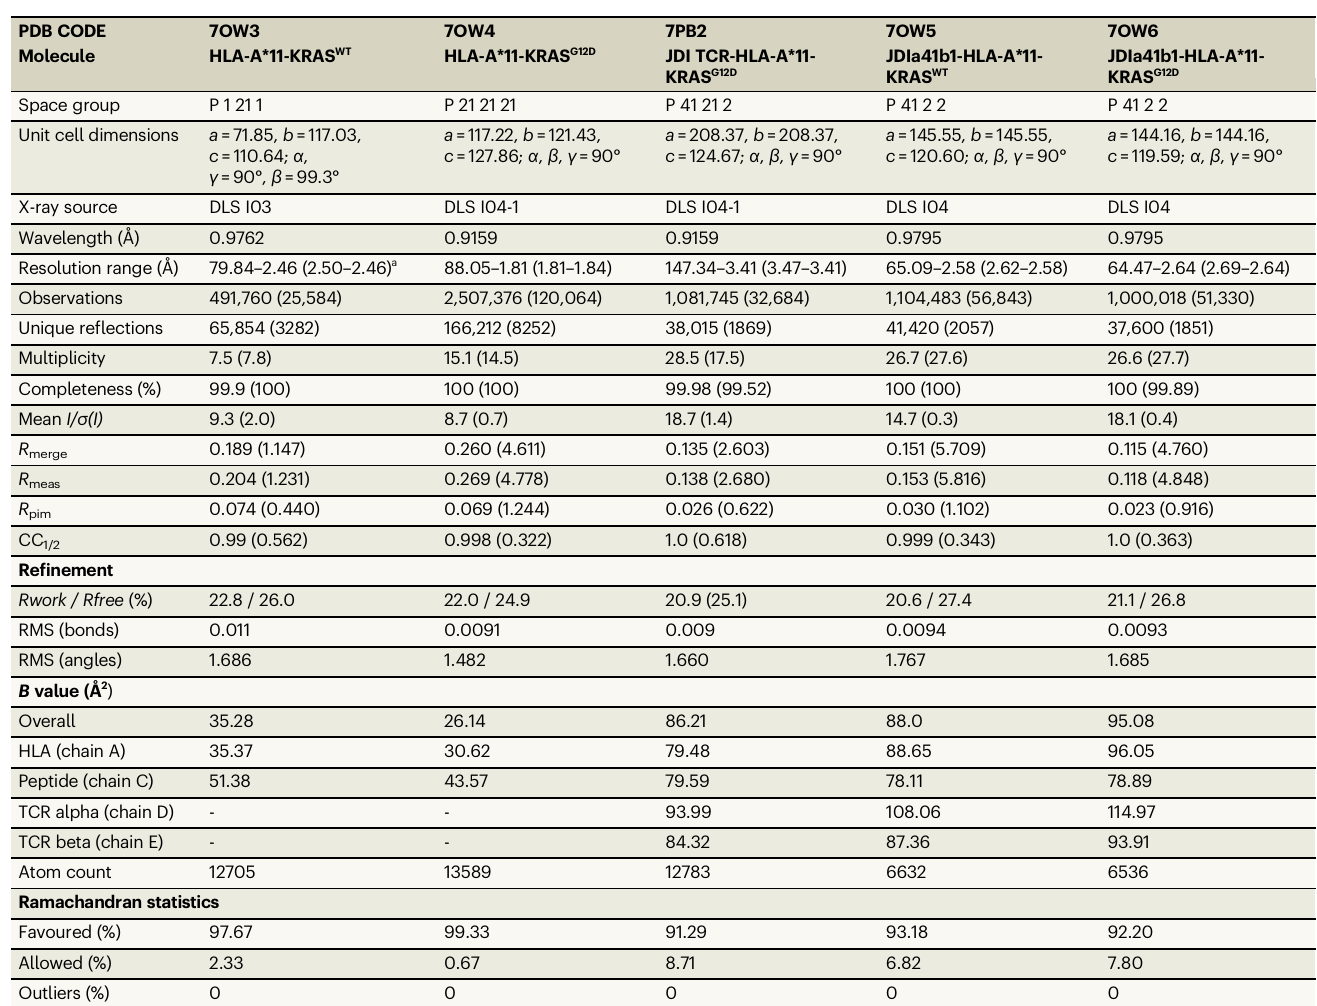
Table 3 | X-ray data collection and re fi nements